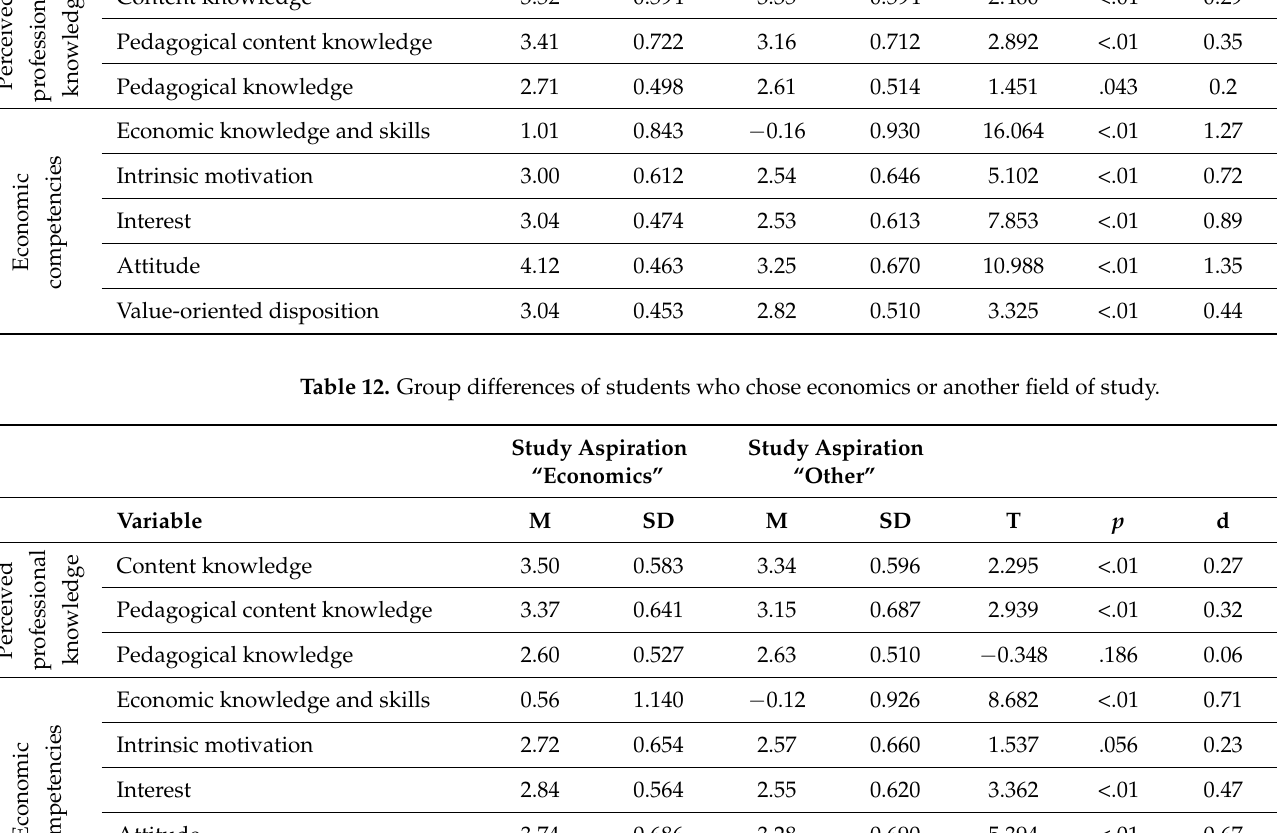
Table 11. Group differences of students with and without the aspiration to study economics. Study Aspiration Study Aspiration “Economics”